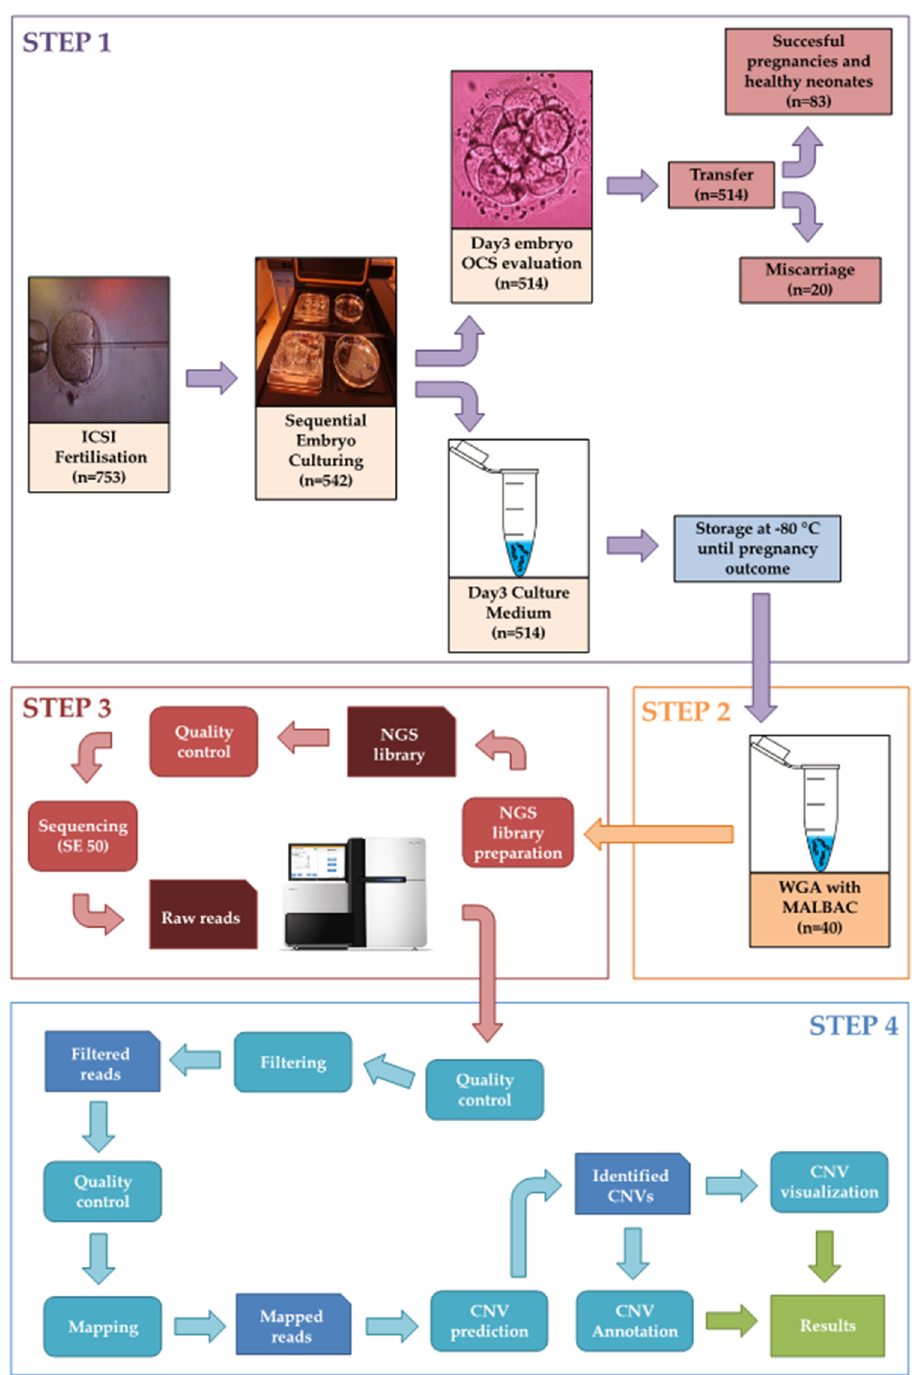
Figure 1. Representation of the NGS-based NIPGT-A workflow including four main steps. Step